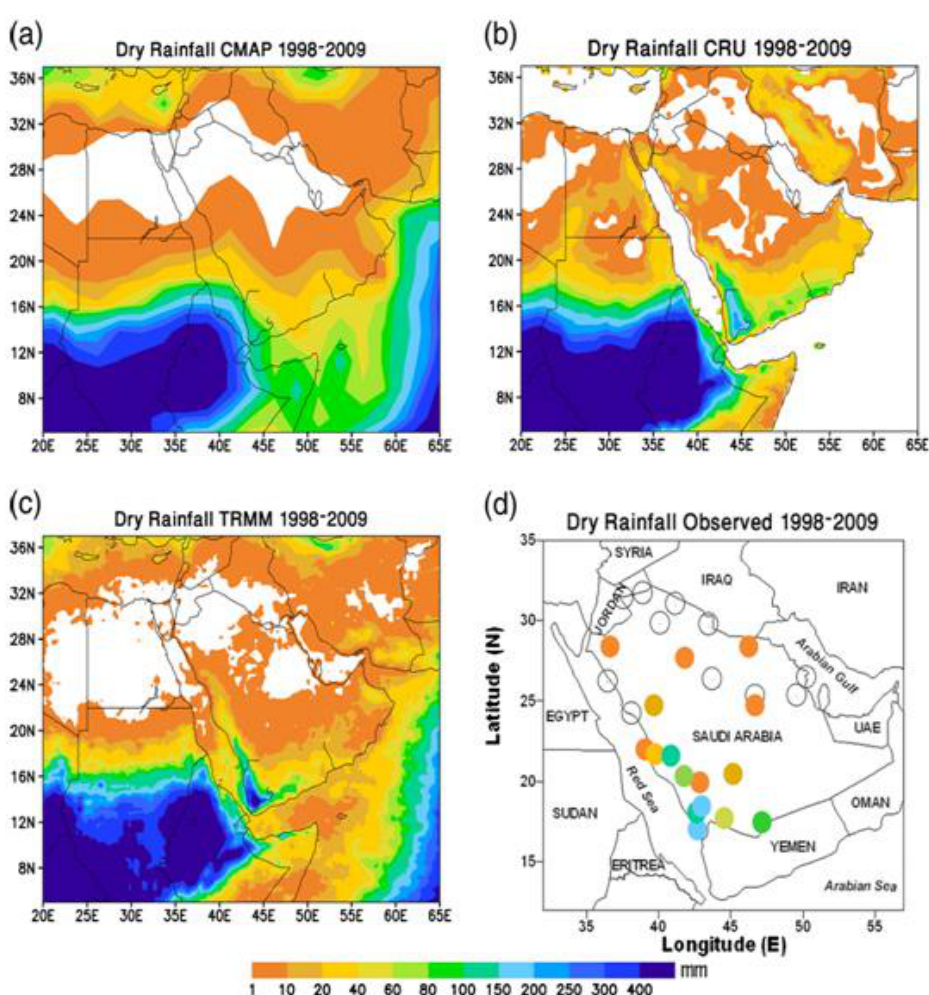
Figure 5. Spatial distribution of the dry season rainfall (mm) averaged over the period 1998– 2009obtained from the ( a ) CMAP; ( b ) CRU; ( c ) TRMM; and ( d ) station datasets. In panel ( d ), the open circles indicate rainfall amounts less than 1 mm